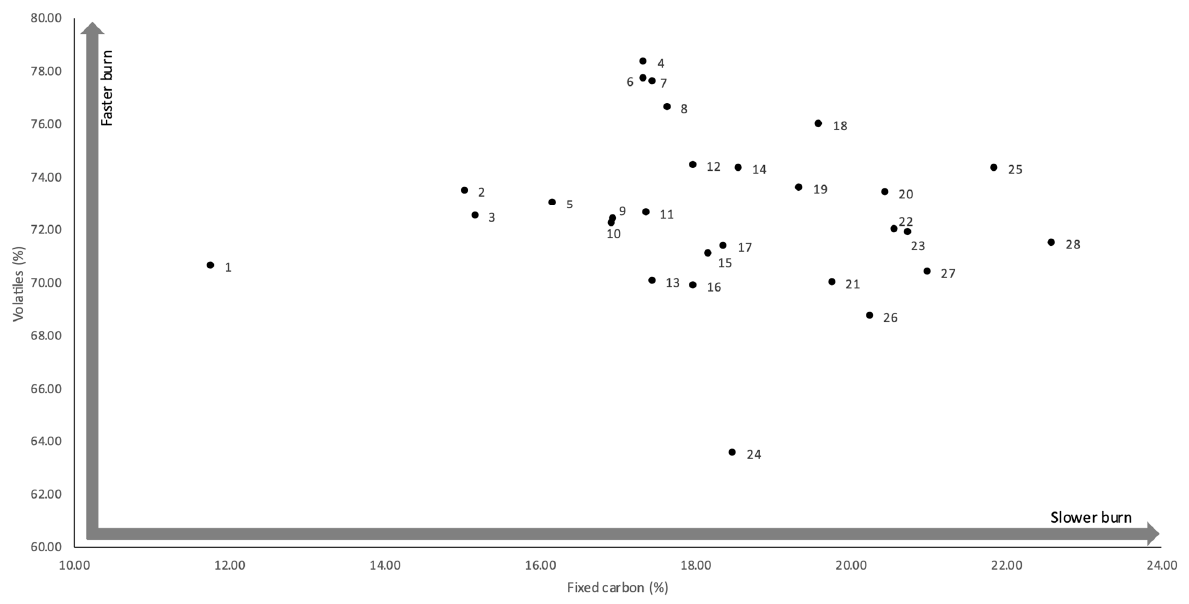
Figure 4. Projection of volatile and fixed carbon contents and their relationship to combustion speed. Legend: 1—